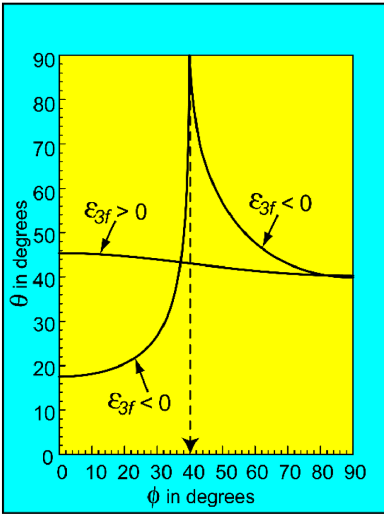
Figure 7. The dependence of the critical angle ( / c in the figure) on Figure 6. The graphs show the range of h over which homogeneous the value of e 3 f < 0, above which the wave number j z is no longer waves can propagate for e 1 s = 3.3856, e 3 s = 2.25, e 1 f = 4, limited by the value of e 3 f when this is negative. When e 3 f > 0 the | e 3 f | = 2.7889. The range extends from h = 0 (cid:3) up to each of the value of j 2 must be less than e 3 f for propagation of hybrid curves in the figure. As / increases, there is little change when z homogeneous modes. If e 3 f < 0, there will be an angle / crit above e 3 f > 0. When e 3 f < 0, there is a rapid increase in the range until, at a which there will be propagation of inhomogeneous modes. particular value / ¼ / , homogeneous waves can propagate at all crit The arrow in the diagram shows the critical angle when angles of h up to 90 (cid:3) . With the parameters given in the text e 3 f = (cid:2) / ¼ 39 : 9 (cid:6) (shown by the dotted line). The upper right hand curve crit shows the decreasing range of h when u increases beyond / ¼ / . crit